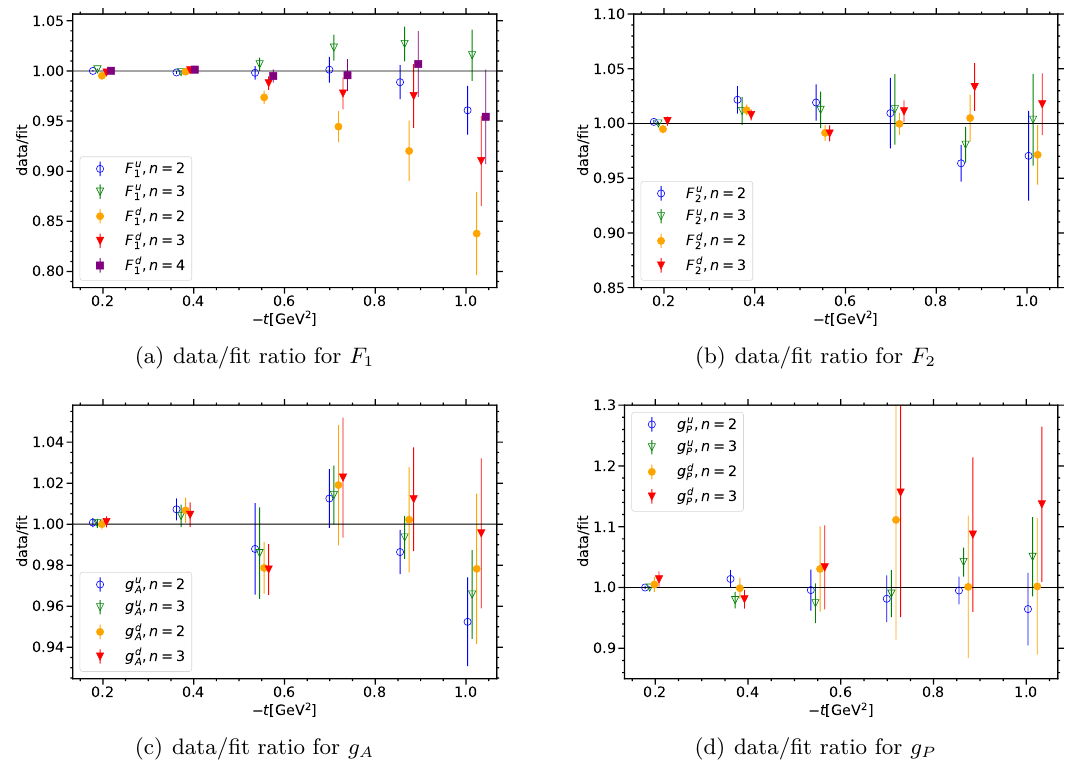
Figure 25 . t -dependence of the ratio of the form factor data and the corresponding fit, where we compare results for different values of the exponent n . For better distinguishability data points for different fits are shifted with different offsets. The results are shown for F g P (d) for each